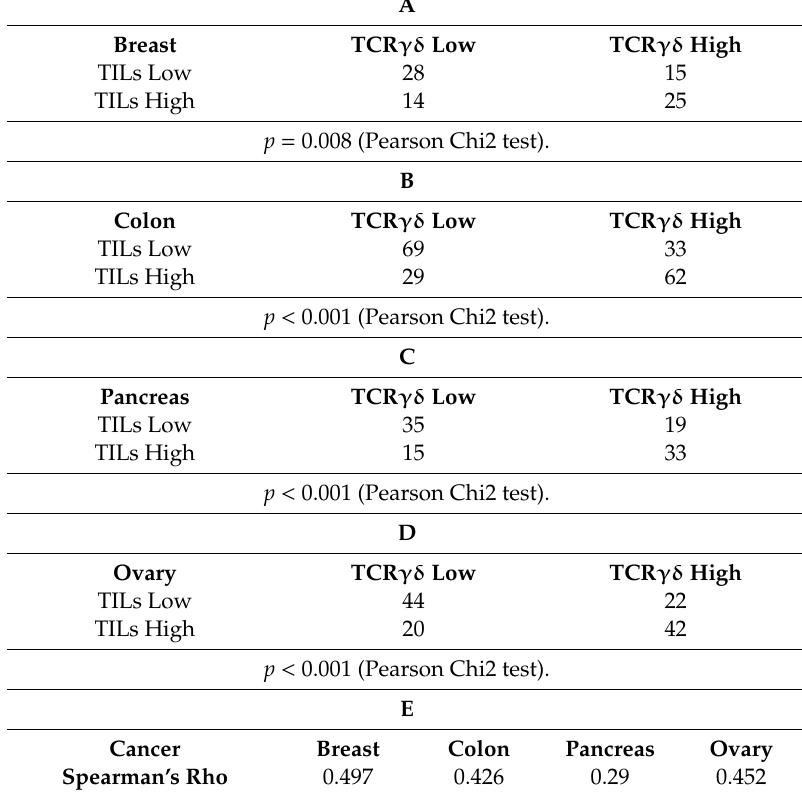
Table 1. Association and correlation analyses between γδ T-cells and tumor-infiltrating lymphocyte (TIL) densities. Association between the γδ T-cell density and TIL density in ( A ) breast cancer ( p = 00.8), ( B ) colon cancer ( p < 0.001), ( C ) pancreatic cancer ( p < 0.001) and ( D ) ovarian cancer ( p < 0.001) (Pearson’s chi-squared test). High and low densities were defined as values above or below the median values. ( E ) Correlation between the γδ T-cell density and TIL density in all cancers. Spearman’s Rho values are shown in the table. No correlation is observed in pancreatic cancer (Rho < 0.4), while a weak correlation is found in breast, colon and ovarian cancers (Rho < 0.6). A Breast TCR γδ